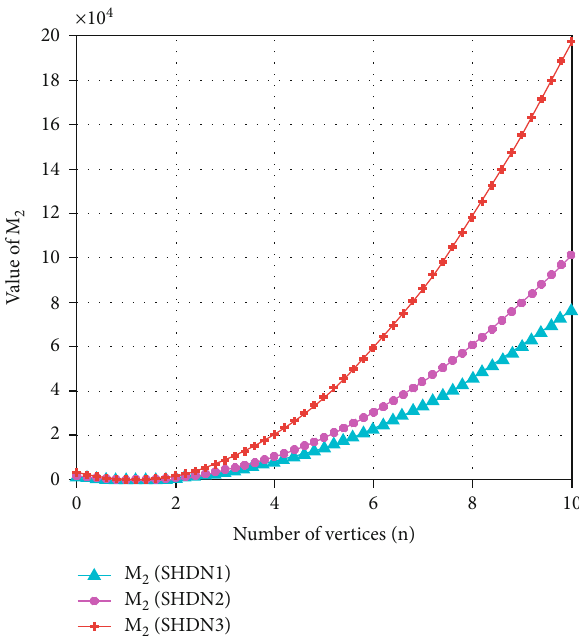
n Þ using 2D graphs 3 ð